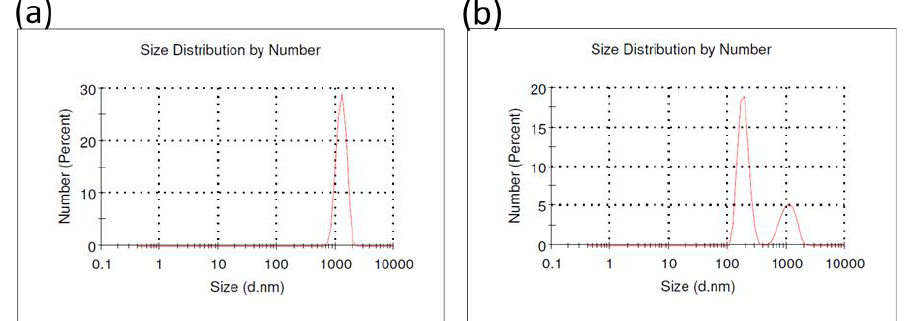
subchronic exposure protocols. ( a ) FF solution (n = 3). ( b ) UFP solution (n = 3). FF solution